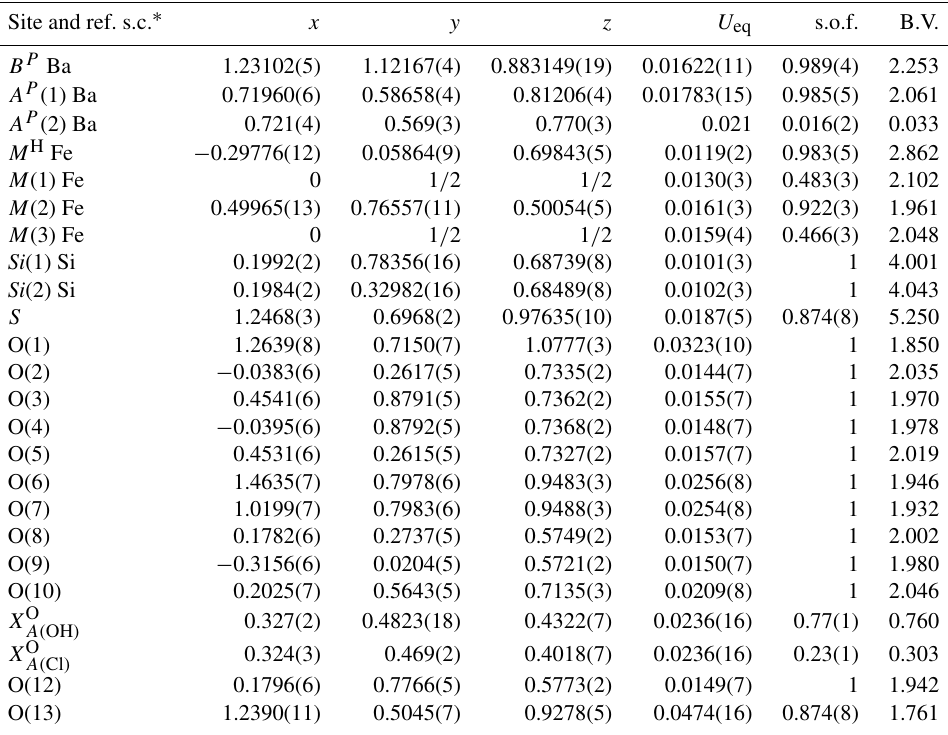
Table 6. Atom coordinates and equivalent isotropic displacement parameters (Å 2 ) for zinkgruvanite. U eq is defined as one-third of the trace of the orthogonalized U ij